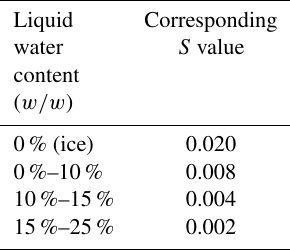
Table 3. Distribution of volcanic ash in model domain among 10 size bins corresponding to the S2 size distribution as given in Mastin et al. (2009). The percentages of mass per bin are specified in the volc_d01.asc name list and may be given any value between 0 and